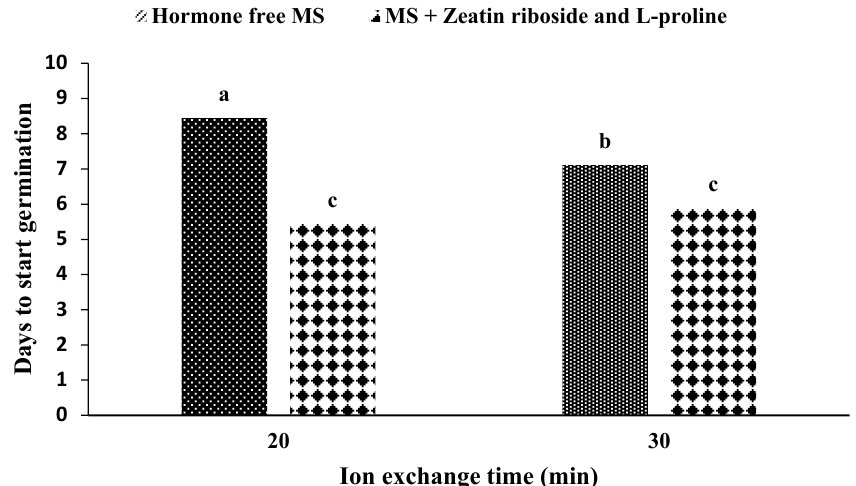
Figure 5. The mean comparison of days until the beginning of germination under the influence of germination medium and ion exchange time in artificial seeds of S. pennata . Bars with a common letter do not differ significantly from each other. p < 0.01 probability level (Duncan’s test). MS—Murashige and Skoog medium.